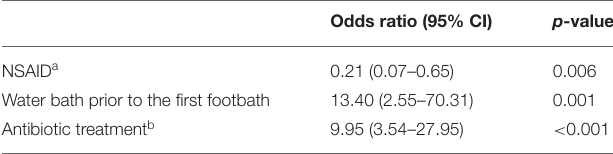
TABLE 3 | Factors affecting the improvement of the overall score from a score ≥ 3 to a score < 3 within 2 weeks ( = 4 footbaths) in individual sheep identified by multivariable mixed effect